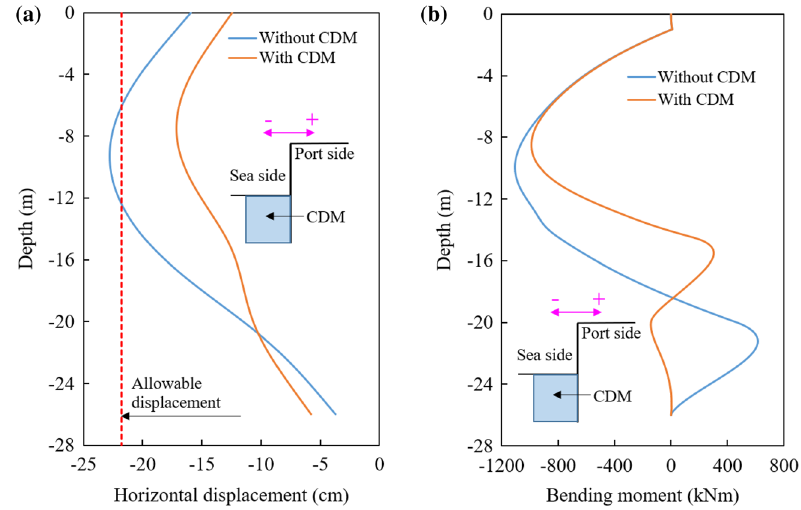
Fig. 6 Horizontal displacement and bending moment versus the depth of the sheet pile at the end of the earthquake (the Coalinga